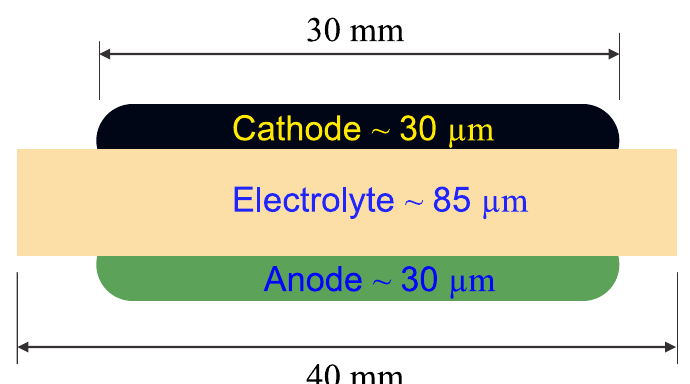
Figure 2. The circular, electrolyte-supported cell used in the experiments, the thicknesses of the electrodes and the electrolyte are